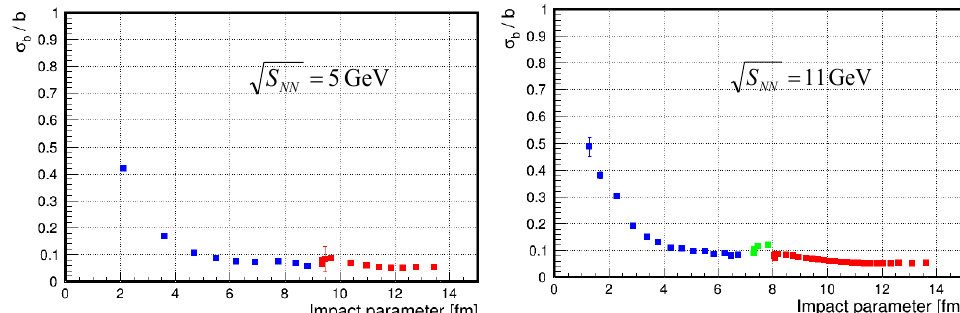
Figure 6. Impact parameter resolution as a function of centrality taken in di ff erent energy deposition bins and in di ff erent regions of energy asymmetry. For bins with negative (positive) A E values are indicated by blue (red) symbols, respectively. For 11 GeV the centrality bins with A E < 0 . 1 are indicated by blue symbols, with the 0 . 1 < A E < 0 . 2 - by green symbols and with A E > 0 . 2 - by red